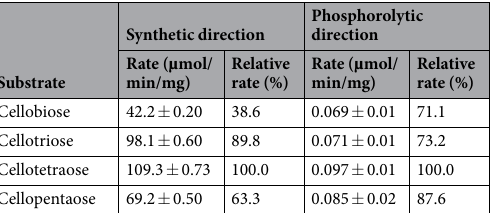
Table 2. Substrate specificities of TaCBP on cellodextrins in the synthetic and phosphorolytic reactions. Concentration of each cellodextrin used was 5 mM.